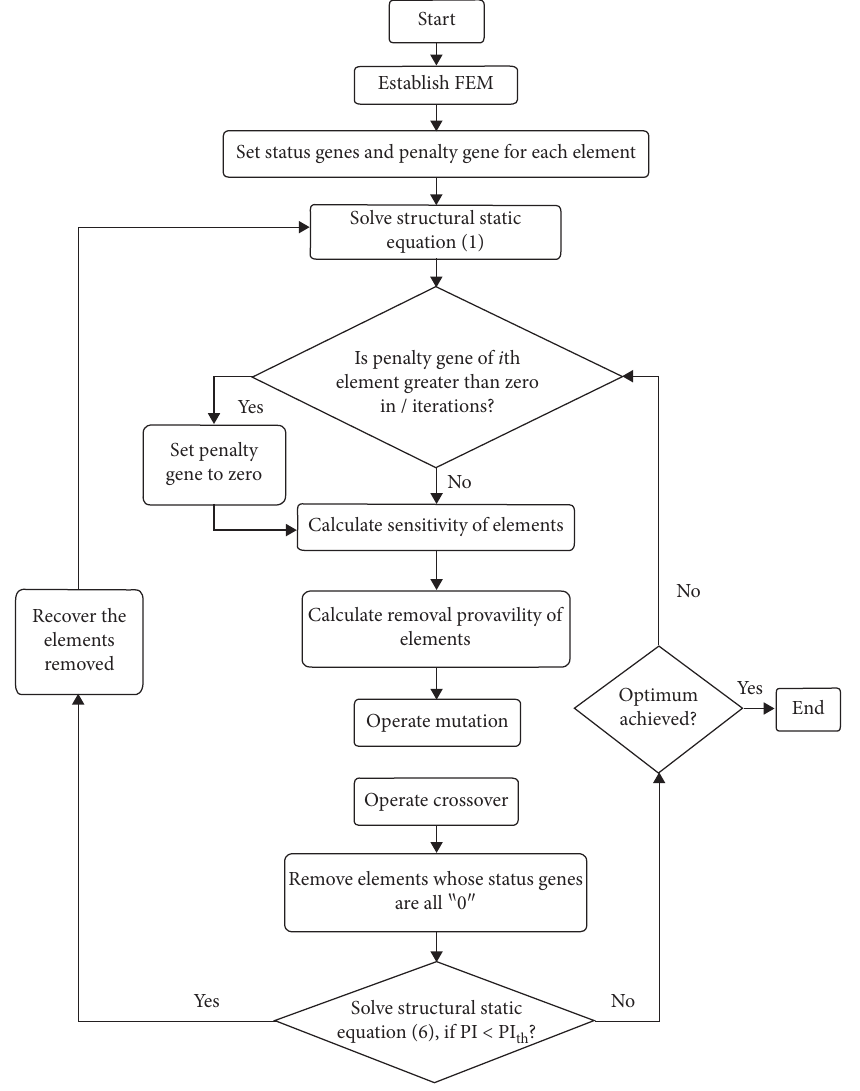
Figure 2: Flowchart of